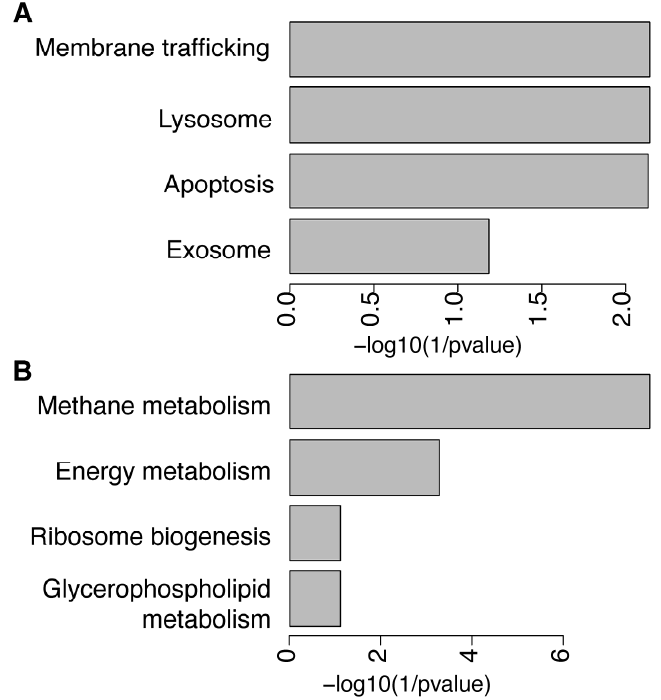
Figure 5. KEGG pathways over-represented ( A ) and under-represented ( B ) in NW group compared to OWOB.